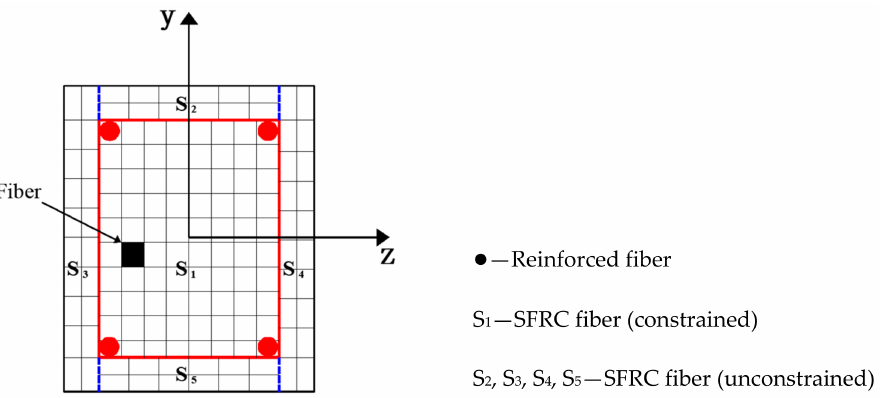
Figure 5. Fiber section model.